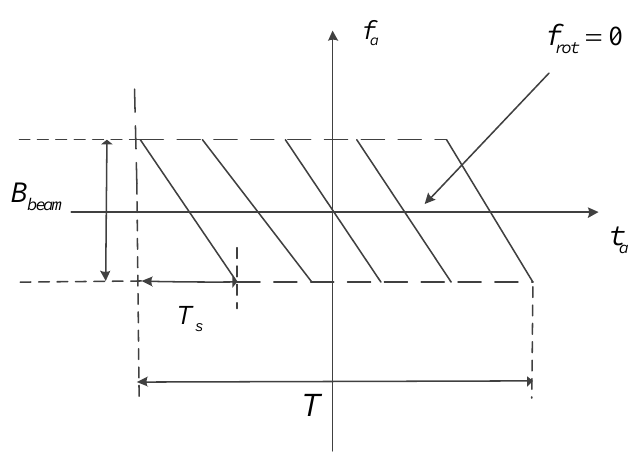
Figure 4. The Doppler time-frequency relationship after dechirp processing, the signal totally overlaps in the support domain which can be weighted. The time-frequency relationship is under the condition of the narrowband signal.